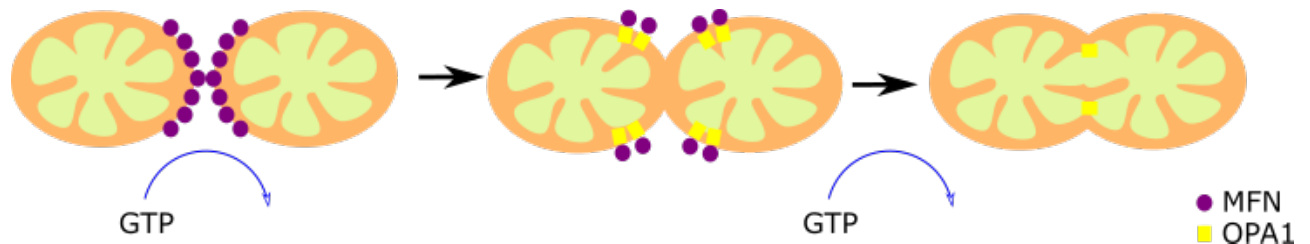
Figure 2. Mitochondrial fusion. The fusion of two preexistent mitochondria is a protective mechanism based on the fusion of the OMM and IMM. The OMM fusion is mediated by MFN1 and MFN2, and the fusion of the IMM is mediated by OPA1. First, MFN1 and MFN2 GTPase activity induce the formation of homo- or hetero-oligomeric complexes in the fusion spot. Then, OPA1-mediated GTP hydrolysis promotes the membrane fusion.